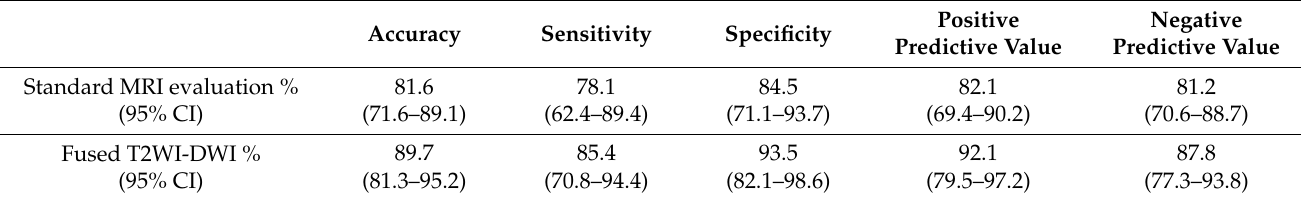
Table 3. Diagnostic performance of the standard MRI evaluation and fused T2WI-DWI images in evaluating the degree of myometrial